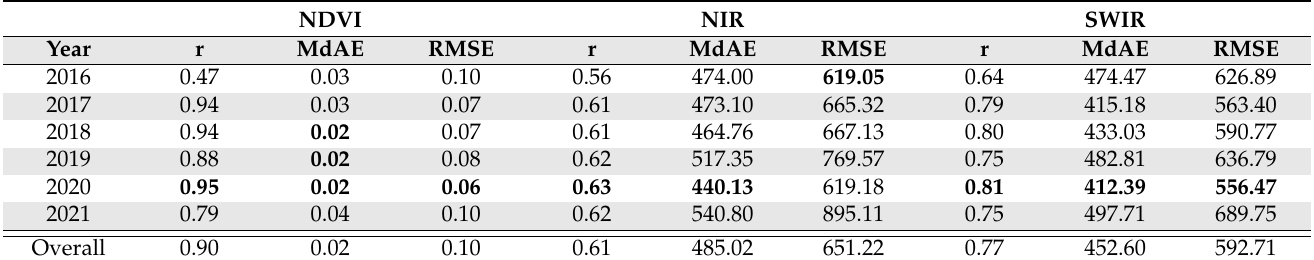
Table 2. Accuracy assessment (Pearson’s r, median absolute error, and root mean square error) between true values and model predicted values for independent test samples for each year of the study. Bold text indicates best result for that column. NDVI